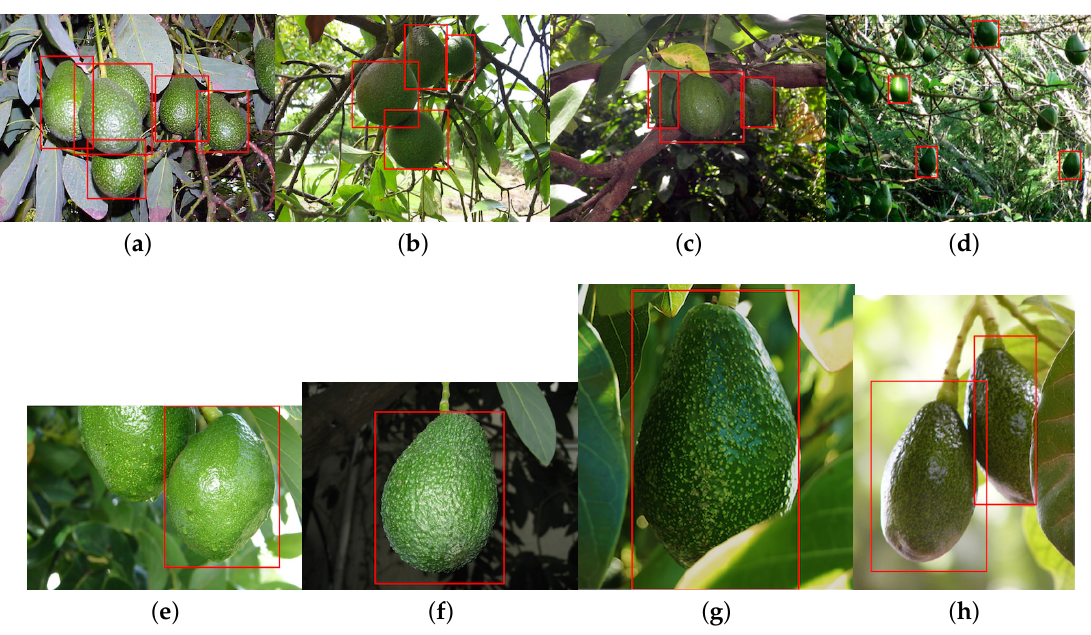
Figure 18. Eight instances ( a – g ), and ( h ) of avocado detection (varying levels of ripeness). Images are obtained from Google Images.